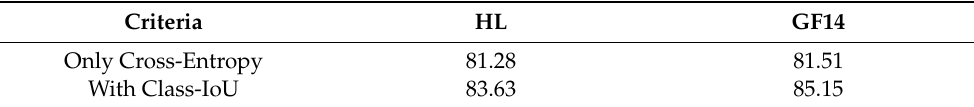
Table 6. Average Accuracy results (%) by selecting 10% labeled